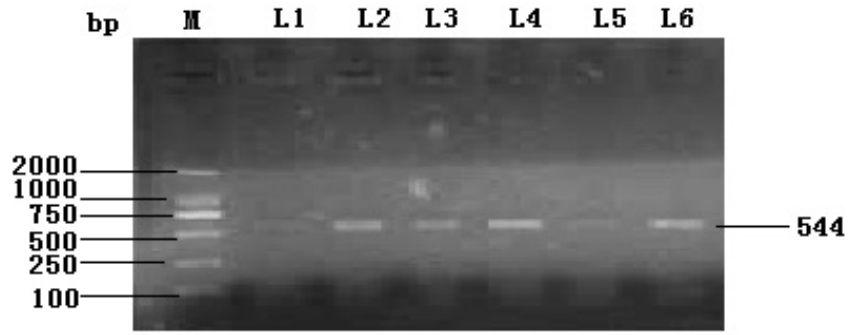
Figure 1. PCR products of IGF2 gene coding sequence in Tianzhu white yak. M , marker, L1 , L2 , L3 , L4 , L5 and L6 stand for brain, kidney, spleen, liver, ovary and muscle,